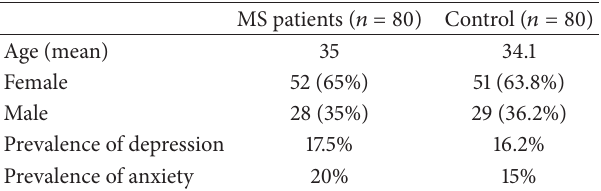
Table 1: Characteristics of controls and MS